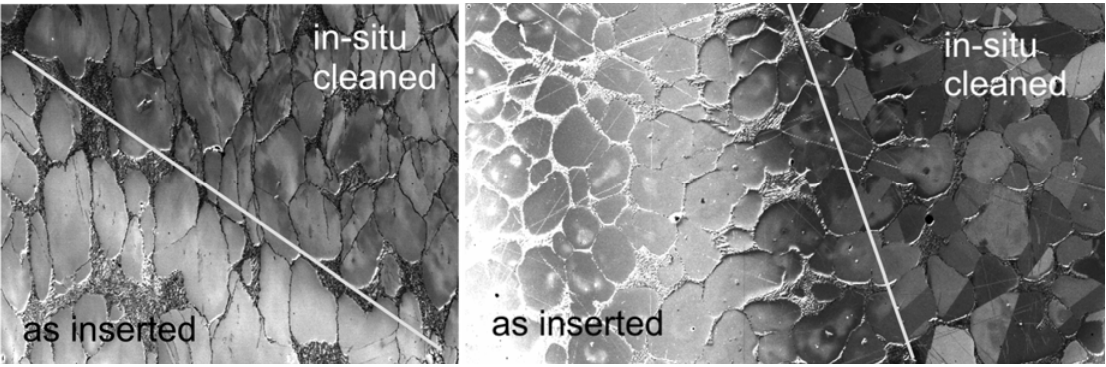
Figure 6. Margins of areas on steel samples, in-situ cleaned with a beam of argon ions in order to remove the oxide layer and other contaminations (3 keV beam incident for 60 min under an angle above 80  with respect to the surface normal); samples in 900 V/mm, landing energy 500